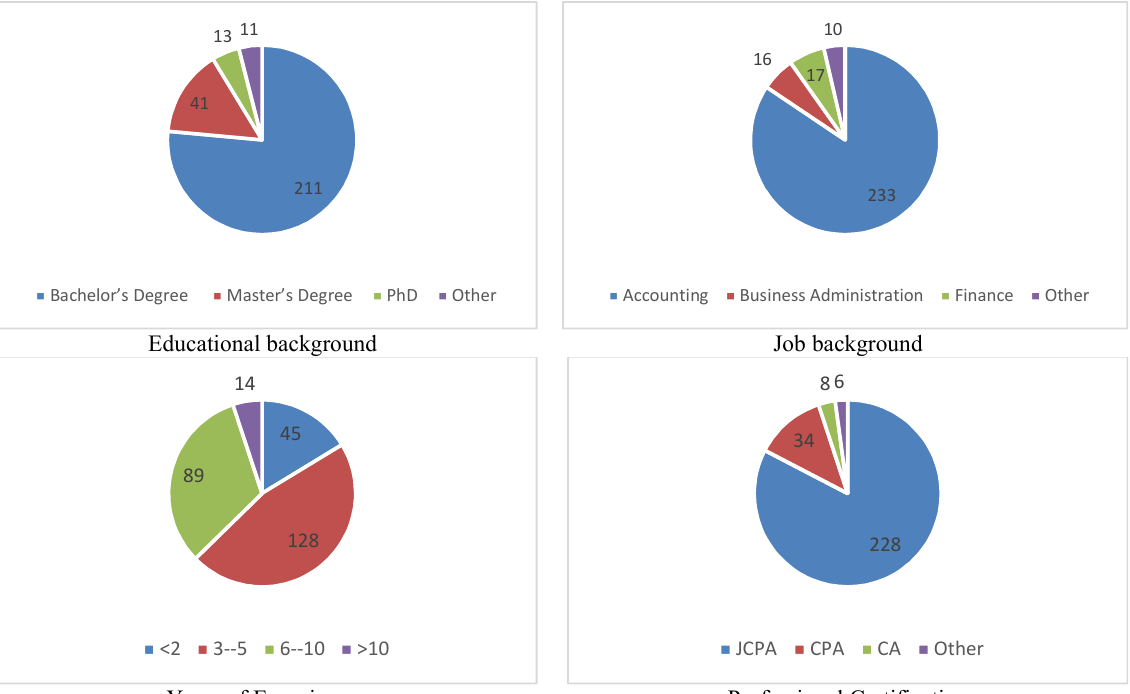
Fig. 1. Personal characteristics of the